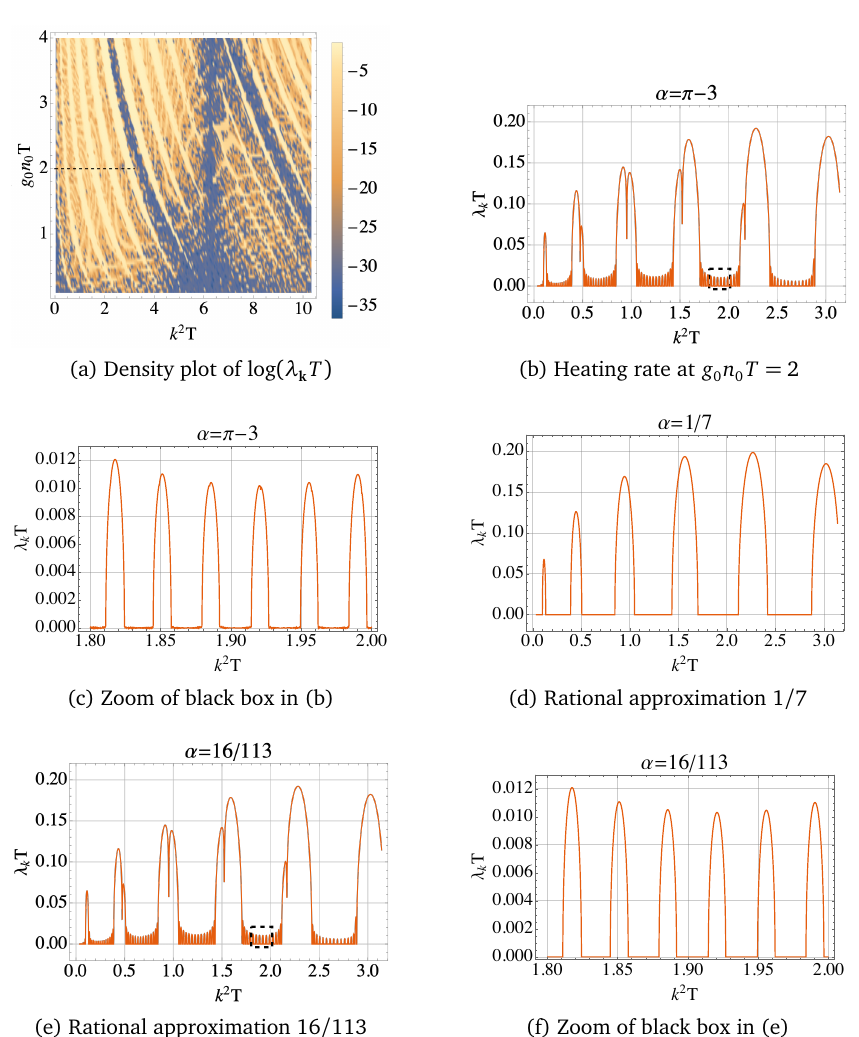
Figure 5: Results for the π modulation of the scattering length. (a). A density plot of ∼ 4 × 10 13 steps. (b-c). The 1D plot T ) determined by taking a period of q log ( λ k 25 T with fixed g n T = 2. (d). The heating rate for rational for the heating rate λ k 0 0 / q = 1 / 7. (e-f). The heating rate for rational approximation approximation x = p 1 1 / q = 16 / 113. By comparing (b-f), we find p / q / q x = p and p governs the 3 3 1 1 3 3 heating rate at different magnitude